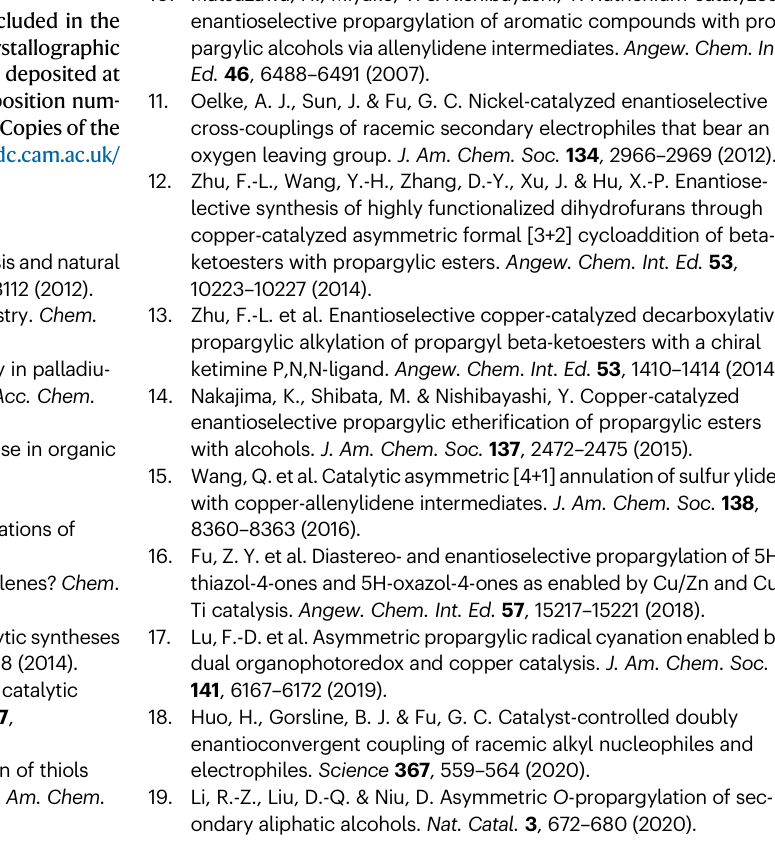
hydroxyphosphineanion 2 ’ toproduce 3 (leftcycle).Undertheacidiccondition,an allylnickelintermediate V undergoes the reaction with 2 ” to furnishesthe fi nal1,3- dienyl isomer 4 (right